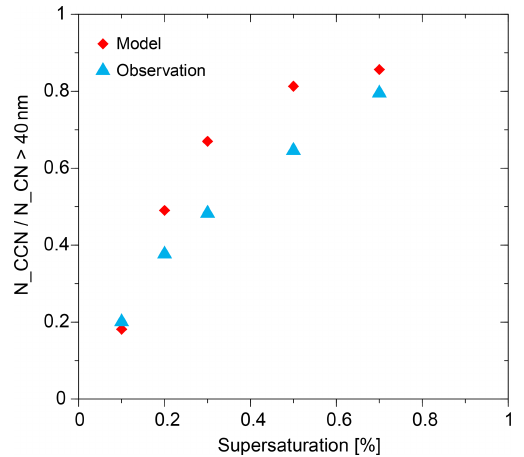
Figure 5. Simulated and observed fraction of CCN number concen- tration to the total number concentration of particles with a diameter larger than 40nm (N_CCN/N_CN) as a function of